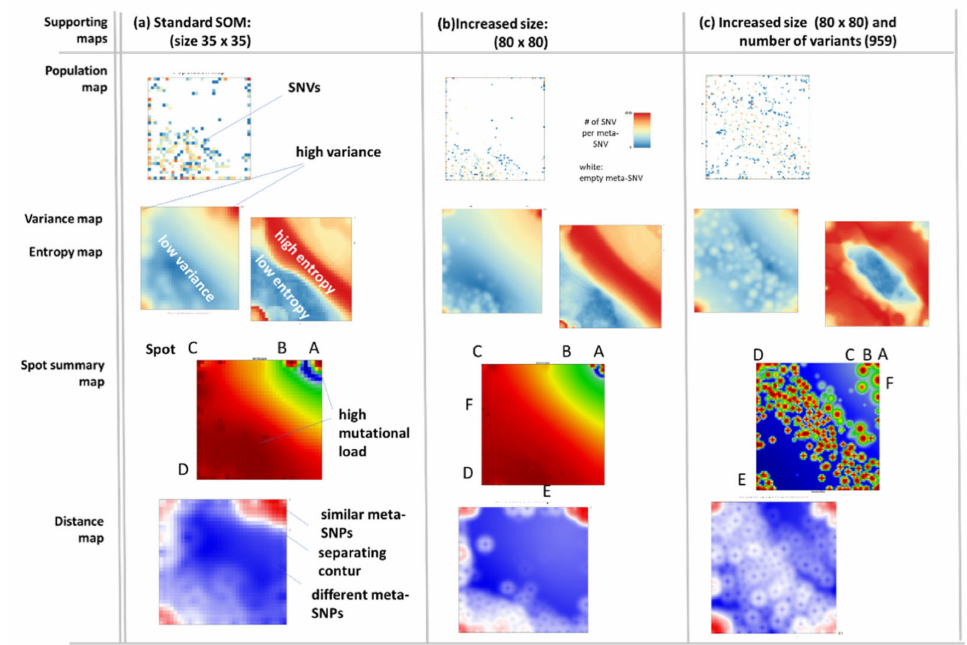
Figure A1. Comparison of SOM- and sample-size using supporting maps. Increasing size of the SOM retains its internal structure. In conclusion, SOM of standard size (35 × 35) well reproduces the landscape of the data. Supporting maps were described previously [15]. In short: the population map shows the number of SNVs per pixel/meta-SNV. Increasing size increases the amount of empty meta-SNVs (white) but virtually leaves the occupied meta-SNV unchanged. The variance and entropy maps color code the variance and entropy of the meta-SNV. Largest variance (red) is found in the highly populated ‘spot’ areas. Entropy is maximum in the areas of intermediate variance. The spot summary map provides an overview about the spots of high mutational load seen in the individual portraits of variants. The distance map color codes the intrinsic distance metric of the SOM. White ‘halos’ surround clusters of SNV-modes collecting meta-SNV of similar profiles. A nearly doubled number of variants (949) mostly of non-VOC types shifts the SNV-floor towards the central part of the SOM-image. In conclusion, the particular size of the SOM and number of variants considered distorts the SNV-landscape obtained but reproduces its basic features. Their interpretation relates consequently to the particular parametrization of the